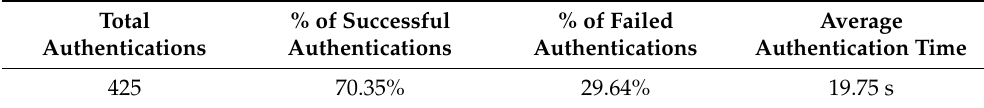
Table 2. Authentication process information.